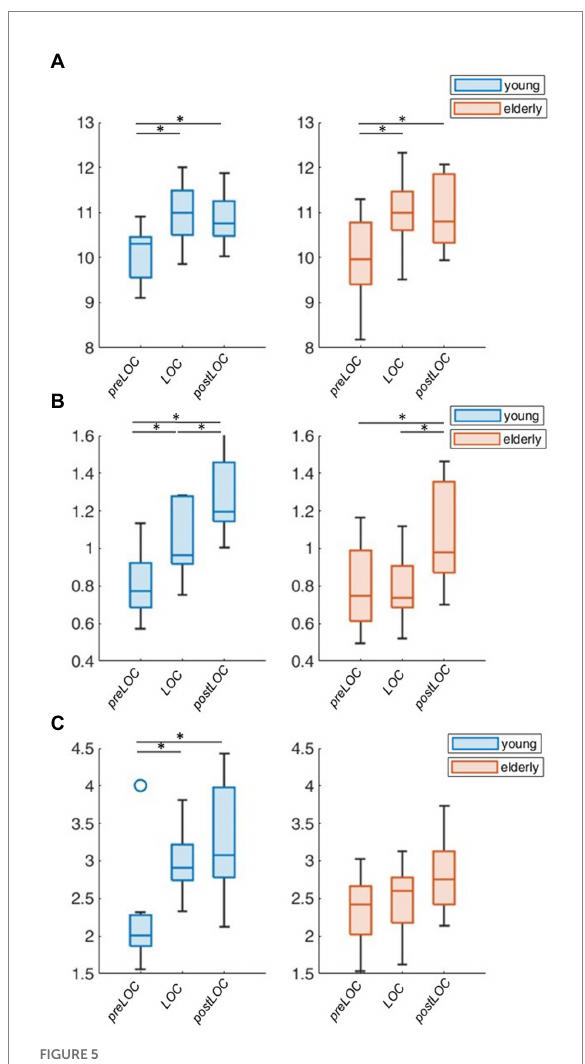
FIGURE 5 Group-wise boxplots of alpha peak characteristics over